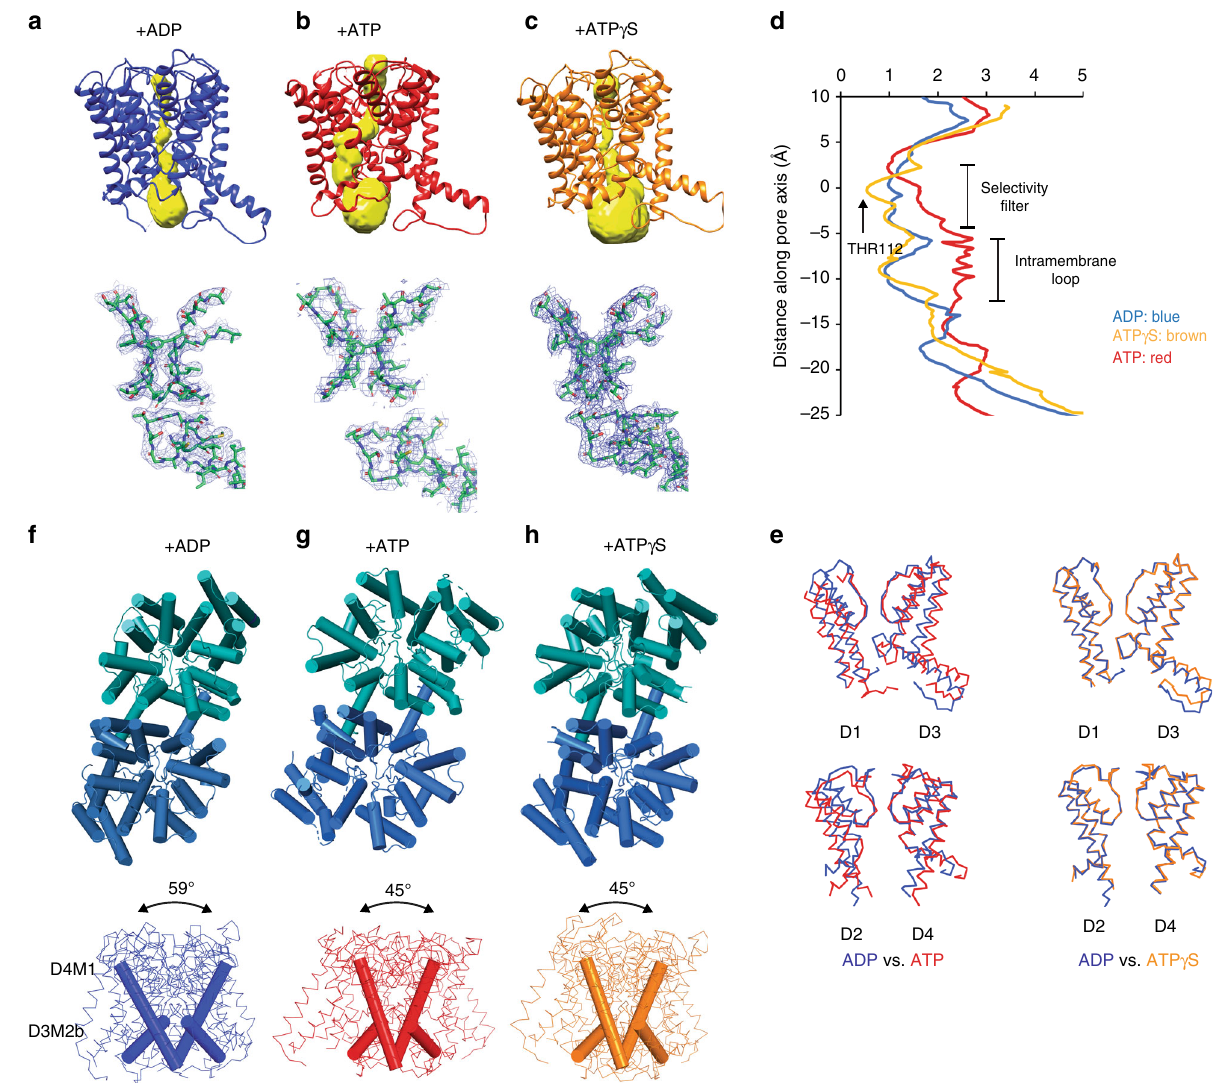
Fig. 5 Conformational changes within TrkH. a – c Top: Surface representations (yellow) of the ion permeation pathways of TrkH from TrkHA-ADP ( a ), TrkHA-ATP γ S ( b ), or TrkHA-ATP ( c ), plotted using the program HOLE 16 . Bottom: Stick representations of the selectivity fi lter and intramembrane loop in TrkH from TrkHA-ADP ( a ), TrkHA-ATP γ S ( b ), or TrkHA-ATP ( c ). The 2Fo-Fc electron density maps are shown in blue meshes contoured at 1.0 σ . d Radius of the ion permeation pathways, as calculated by HOLE 16 . e TrkH protomers from TrkHA-ADP (blue), TrkHA-ATP γ S (orange), or TrkHA-ATP (red) rendered in ribbons superimposed at the selectivity fi lters, showing either the D1 and D3 domains (top) or the D2 and D4 domains (bottom). f – h Top: TrkH protomers from TrkHA-ADP ( f ), TrkHA-ATP ( g ), TrkHA-ATP γ S ( h ), rendered in cylinders viewed from the periplasmic side. Bottom: TrkH protomers from TrkHA-ADP ( f ), TrkHA-ATP ( g ), or TrkHA-ATP γ S ( h ) rendered in ribbons viewed within membrane. The D4M1 and D3M2b helices at the dimer interfaces are rendered in